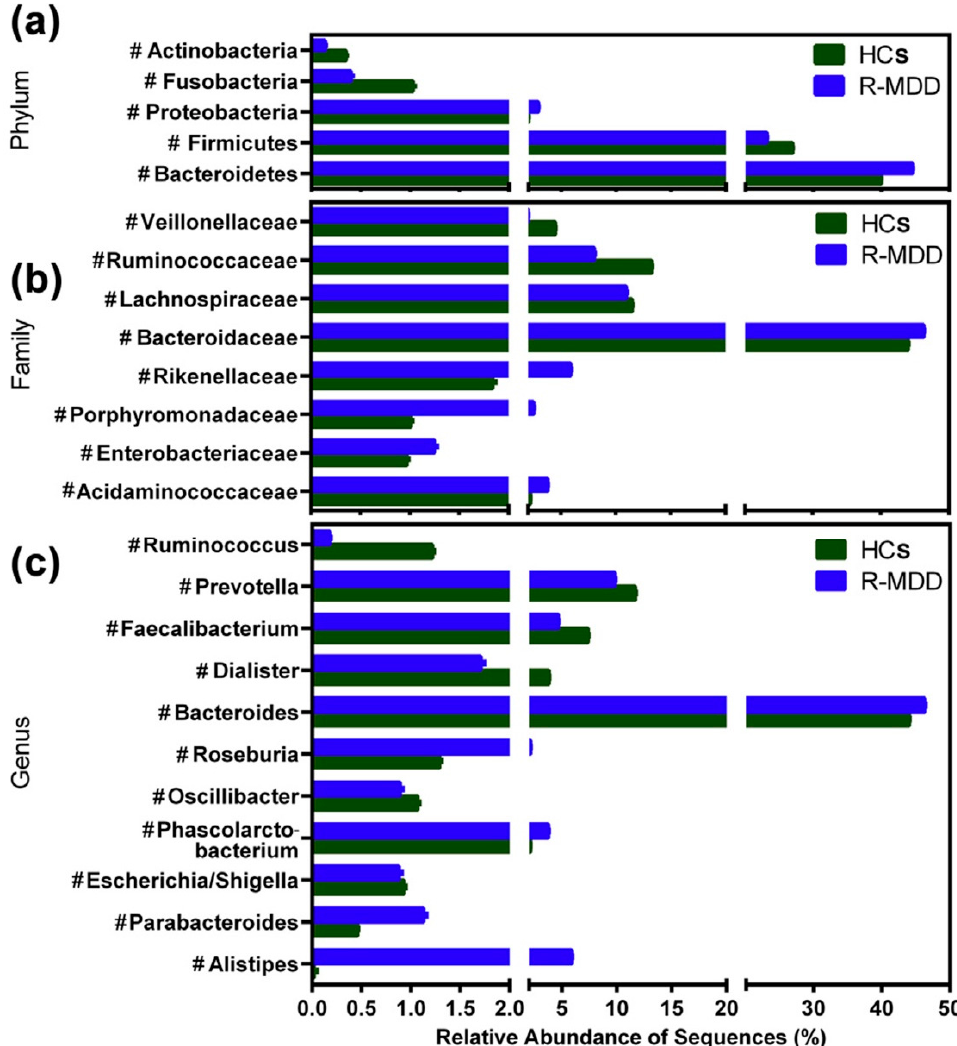
Figure 3. Taxonomic changes in fecal microbiota and relative abundance between healthy control (HC) and MDD groups at the levels of bacterial phylum ( a ), family ( b ), and genus ( c ). Enterobacteri- aceae, Fusobacteriaceae, and Rikenellaceae were considerably higher, but Prevotellaceae, Bacteroidaceae , and Ruminococcaceae were significantly lower in MDD when compared to HC. Alistipes, Blautia, Lachnospiracea, Parabacteroides, Clostridium XIX, and Oscillibacter are more prevalent in MDD than in HC. Prevotella, Bacteroides, Faecalibacterium, and Ruminococcus are less abundant in MDD than in HC. The figure is reused as per journal copyright permission